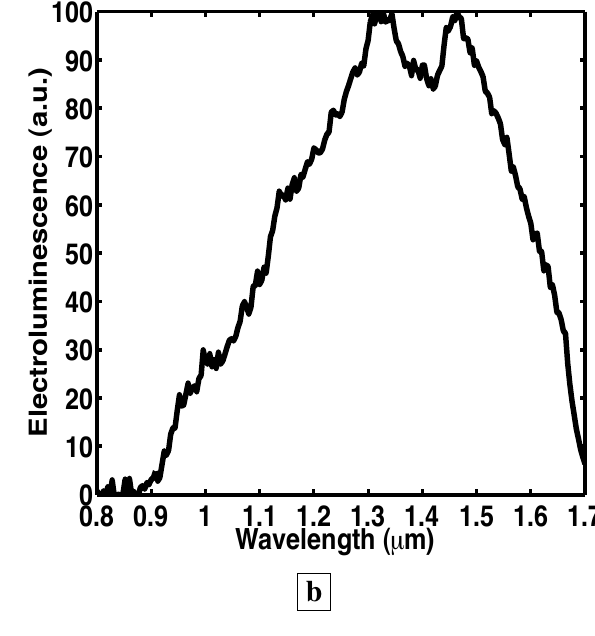
Figure 9 . Room temperature EL [7] from a device which does not have a p-layer. a, In a device consisting of only the n-type deep-center-layer, holes are created via impact ionization of electrons over a large volume of the deep-center-layer (all along the electron paths). b, The EL spectra from the deep-center-layer looks a lot like the PL when the holes are created in a large volume of the deep-center-layer (all along the electron paths). This is unlike Figure 8a, where the EL spectra exhibits a spectral blue-shift relative to the PL, and where the holes in ) of the Figure 8a exist only in a small volume (the first L P